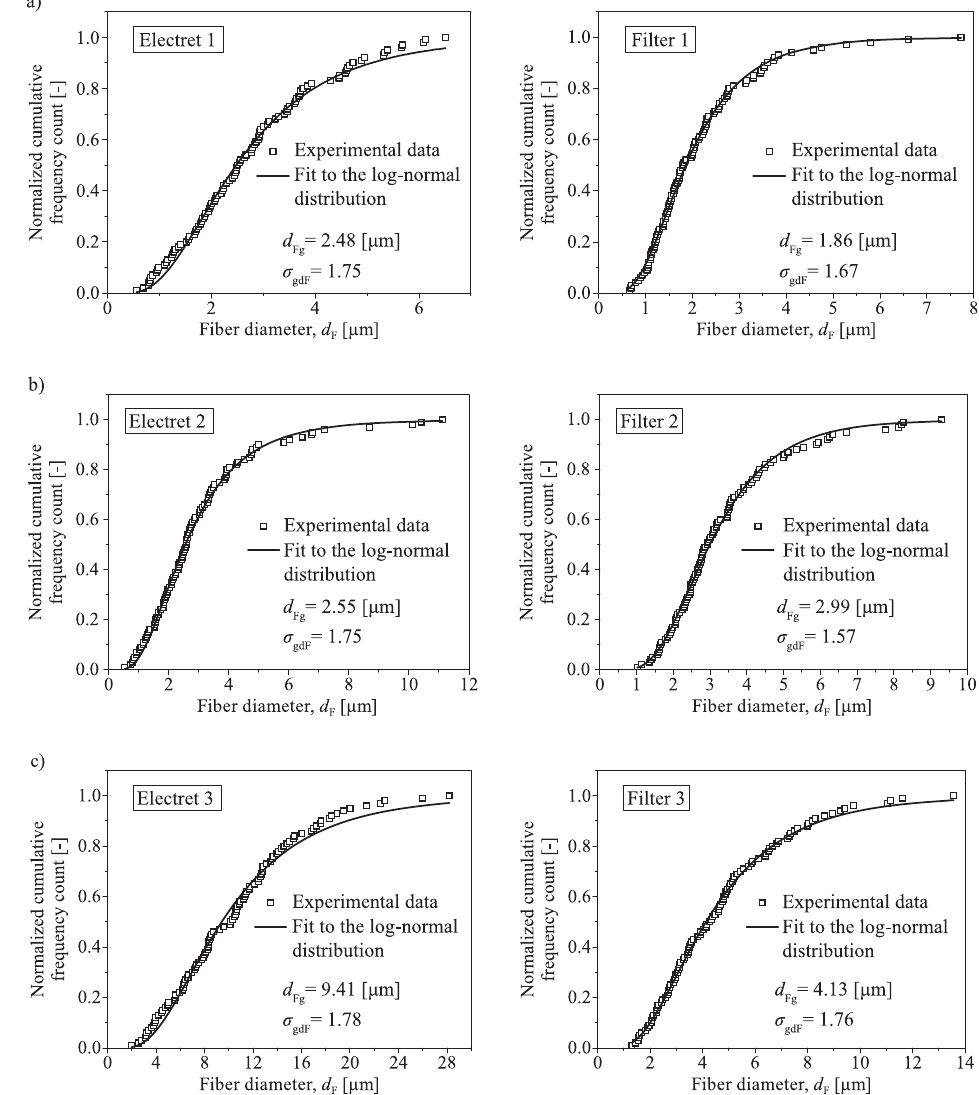
Fig. 3 Fiber size distributions of the fibrous electret and mechanical filters: (a) Electret 1 and Filter 1, (b) Electret 2 and Filter 2, (c) Electret 3 and Filter